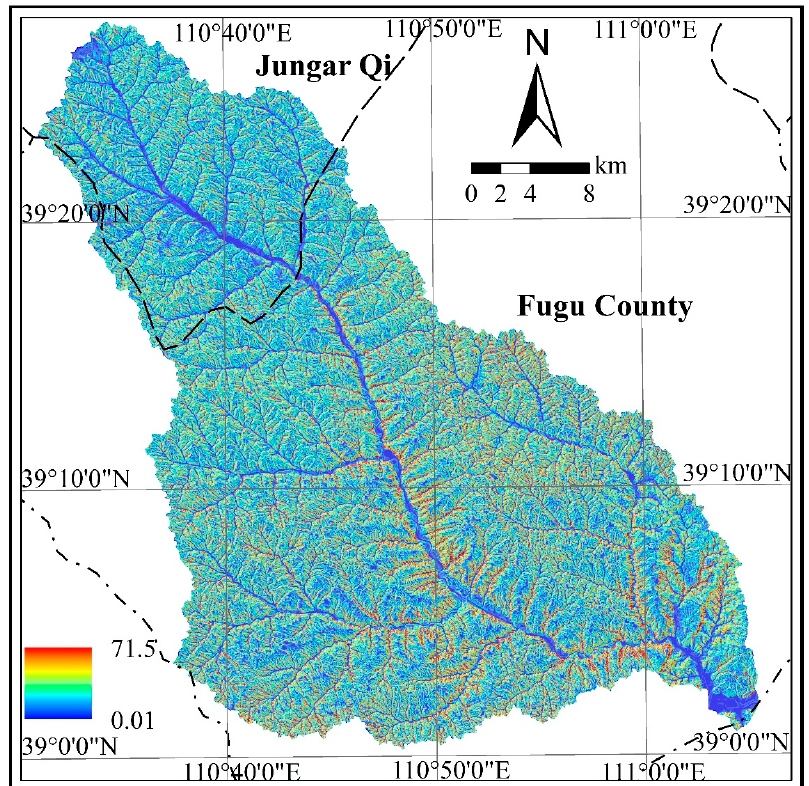
Figure 8. LS factor using sub-basin splitting based parallel algorithm.